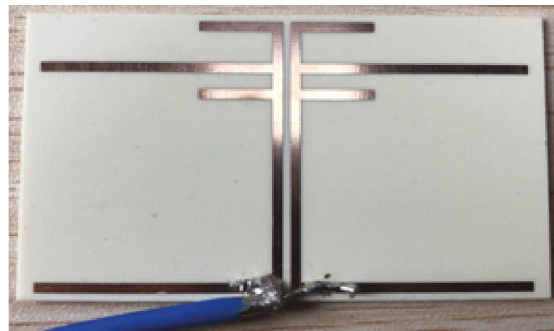
Figure 10: The fabricated prototype of the proposed antenna.